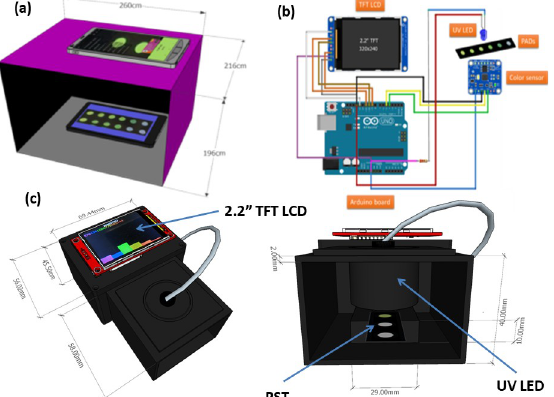
Fig 1. (a) Design sketch for SP detection using a smartphone; (b) Electrical circuit of Arduino-based device; and (c) Specific design of home-made reader: AS7262 6-channel VIS sensor, UV-LED 365 nm as an excitation source, 2.2” thin-film transistor liquid crystal display (TFT LCD), and controller board ATmega-328P microcontroller Arduino Uno